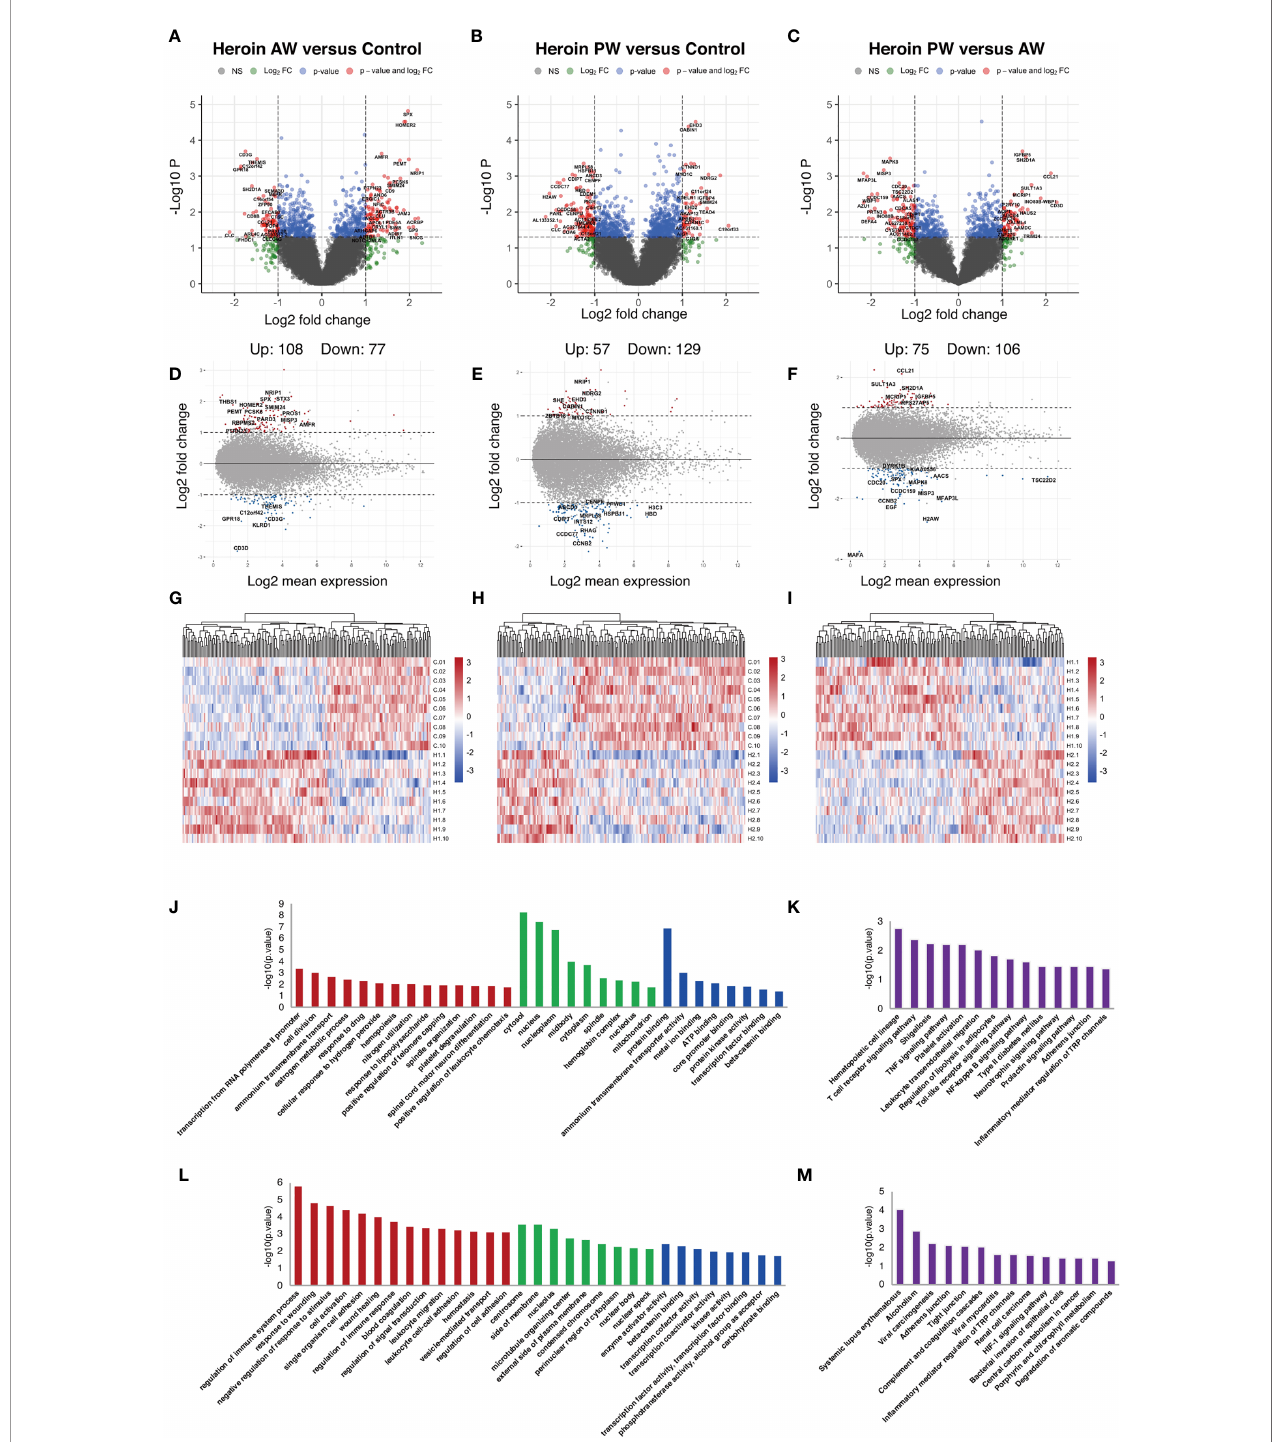
FIGURE 2 | Identi fi cation and functional enrichment analysis of differentially expressed Ex-mRNA. (A, D, G) The volcano plot and MA plot (A, D) and hierarchical clustering heatmap (G) of differentially expressed exosome mRNAs in Heroin AW versus HC (P < 0.05, fold change > 1.5). (B, E, H) The volcano plot and MA plot (B, E) and hierarchical clustering heatmap (H) of differentially expressed exosome mRNAs in Heroin PW versus HC (P < 0.05, fold change > 1.5). (C, F, I) The volcano plot and MA plot (C, F) and hierarchical clustering heatmap (I) of differentially expressed exosome mRNAs in Heroin AW versus Heroin PW (P < 0.05, fold change > 1.5). (J – M) Top enrichment of KEGG pathways related to differentially expressed exosome mRNAs in Heroin AW versus HC (J, K) and in Heroin PW versus HC (L, M)